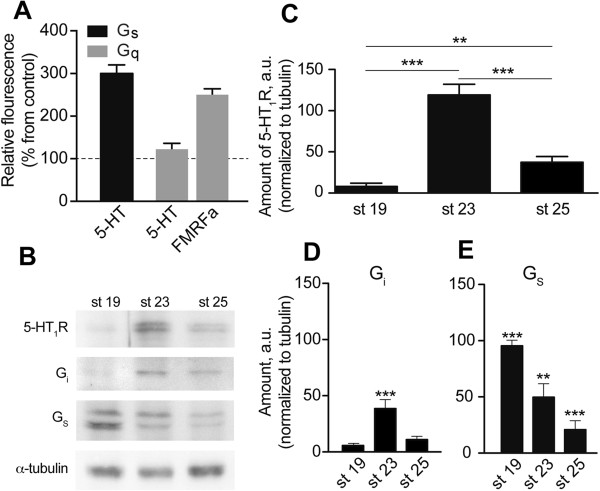
Expression and activation of G proteins and 5-HT1 receptor during H. trivolvis development. (A) (Eu)GTPγS binding assay demonstrates 5-HT-iduced activation of Gs, but not Gq protein in membrane preparations of H. trivolvis. Activation of Gq by FMRFamide was used as a positive control. (B) Western blot representing proteins from membrane preparations of H. trivolvis embryos at different developmental stages. The proteins were visualized with the antibodies against the 5-HT1R, Gi- and Gs-proteins. (C-E) Quantification of protein expression performed by densitometry. Relative amounts of 5-HT1R (C), Gi-protein (D), and Gs-protein (E) are shown at the stages 19, 23, and 25. Expression of 5-HT1 receptor and G proteins undergoes changes during H. trivolvis development. Maximal expression of 5-HT1R and corresponding Gi-protein was obtained at the beginning of metamorphosis (st 23), while Gs-protein was maximally expressed at the premetamorphic stage (st 19) and gradually decreases by the metamorphic stage (st 25). Each value represents the mean ± s.d. (n = 4). A statistically significant difference between values is noted (**, p <0.01, ***, p <0.001).